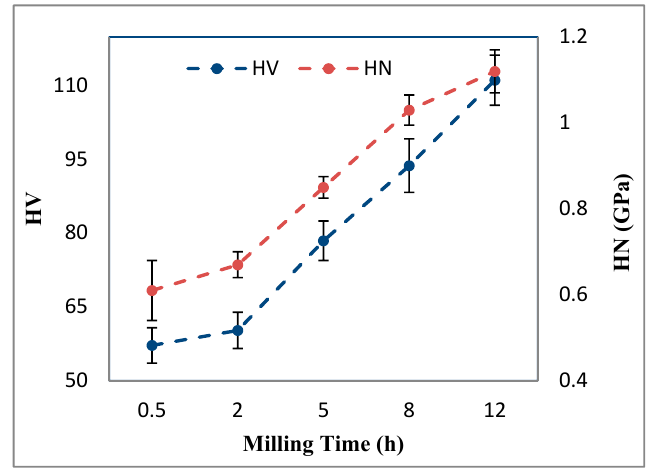
Figure 9. Variation of micro-hardness ( HV ) and nano-hardness ( HN ) of Al-5Al 2 O 3 composites as a function of milling time.